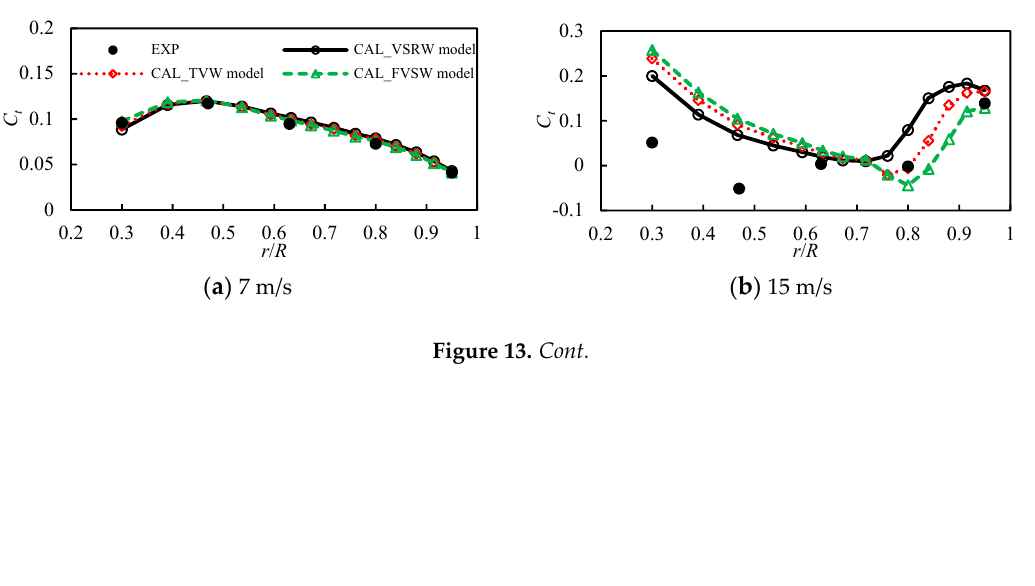
Figure 12. Comparison of the distributions of the computed normal force coefficients at ( a ) 7 m/s, ( b ) 15 m/s, and ( c ) 25 m/s along the blade radial positions for NREL Phase VI in axial steady conditions.